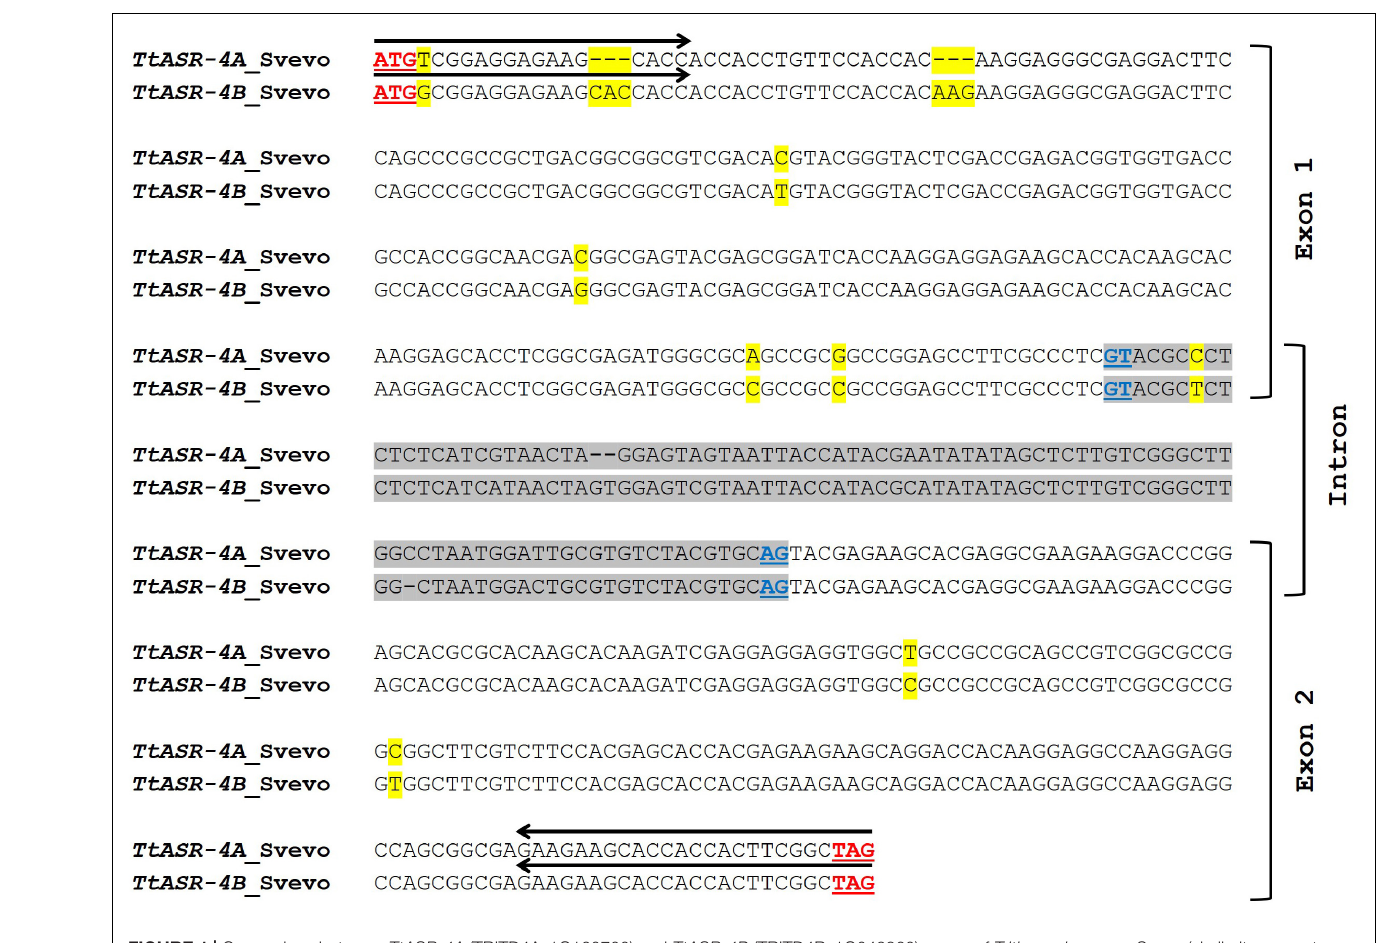
FIGURE 1 | Comparison between TtASR-4A (TRITD4Av1G160700) and TtASR-4B (TRITD4Bv1G043860) genes of Triticum durum cv. Svevo (similarity percentage of 97.3%). The intron sequence is highlighted in gray. Underlined in red are reported the start and stop codons; underlined in dark blue are reported the splice junctions. Black arrows represent Forward and Reverse primers (P6) used for gene amplification in qRT-PCR expression study. SNPs between the two sequences are highlighted in yellow.